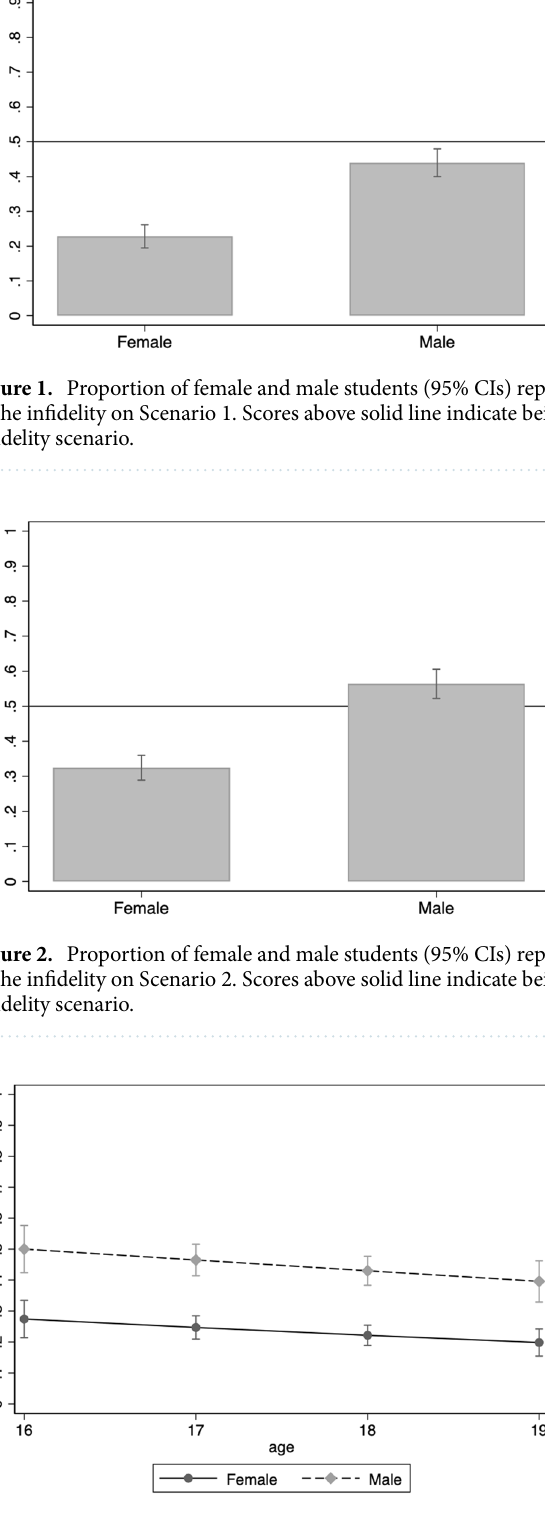
Figure 3. Proportion of female and male students reporting being more upset by the sexual aspect of infidelity at ages 16 through 19 on Scenario